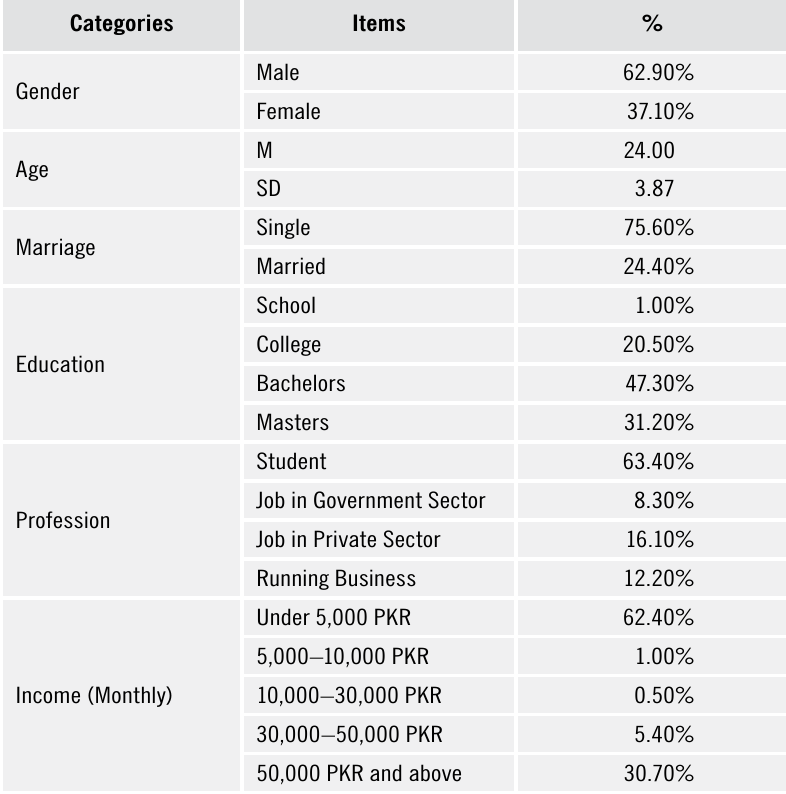
Table 1. Demographic